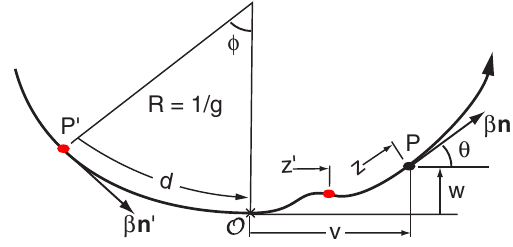
FIG. 1. (Color) The radiation from a particle at point P 0 kicks a particle at point P